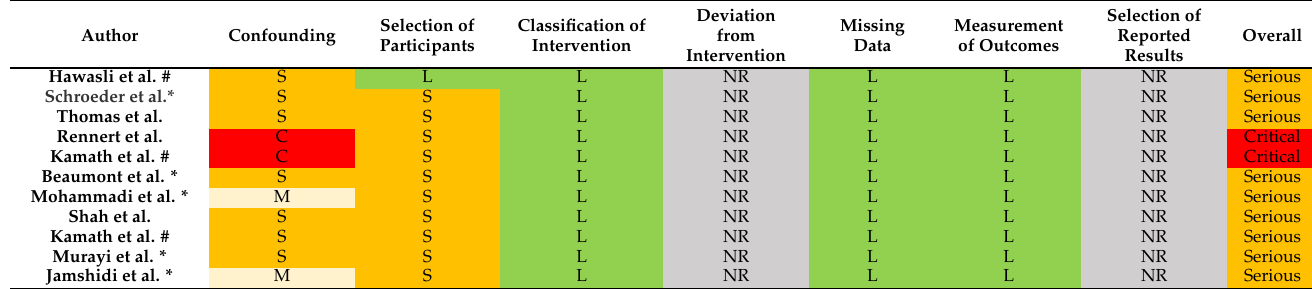
S: serious risk of bias (orange); C: critical risk of bias (red); M: moderate risk of bias (yellow); L: low risk of bias (green). NR = Not reported: data missing given the lack of control group (gray). #: might include part of the same population. *: